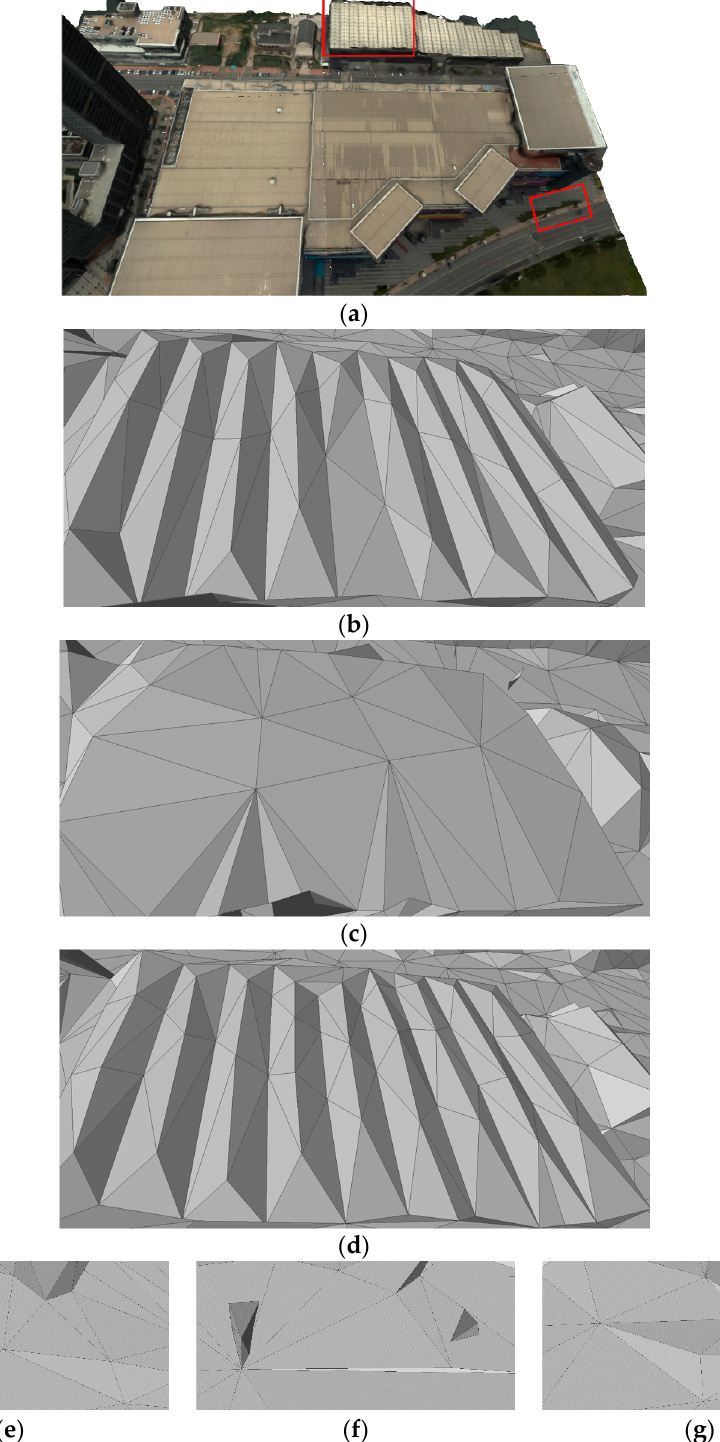
Figure A2. Simplification results at level 2 of tile A. Both regions circled in red in ( a ) are simplified, as shown in the others. There are some differences, similar to Figure 1: mDVDC ( λ = 2.3) performs better than ( d ), while DVDC ( λ = 2.3) performs better than ( f ). Therefore, this article helps solve the problem of deciding on the best algorithms through observation. (a) Input surface with texture; ( b ) aQSlim; ( c ) DVDC ( λ = 2.3); (d) mDVDC ( λ = 2.3); ( e ) aQSlim; (f) DVDC ( λ = 2.3); ( g ) mDVDC ( λ = 2 3 . ).